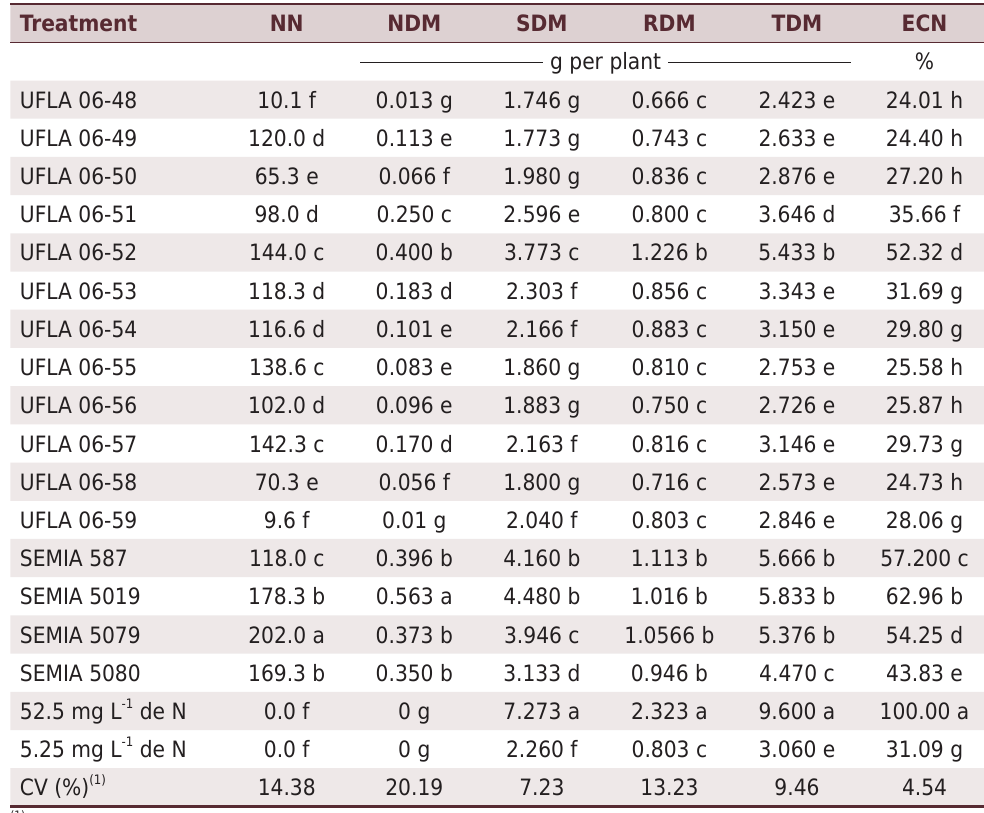
(1) CV: coefficient of variation.Means of 3 replications. Means followed by the same letters in the columns do not differ from each other by the Scott-Knott test at 5 %